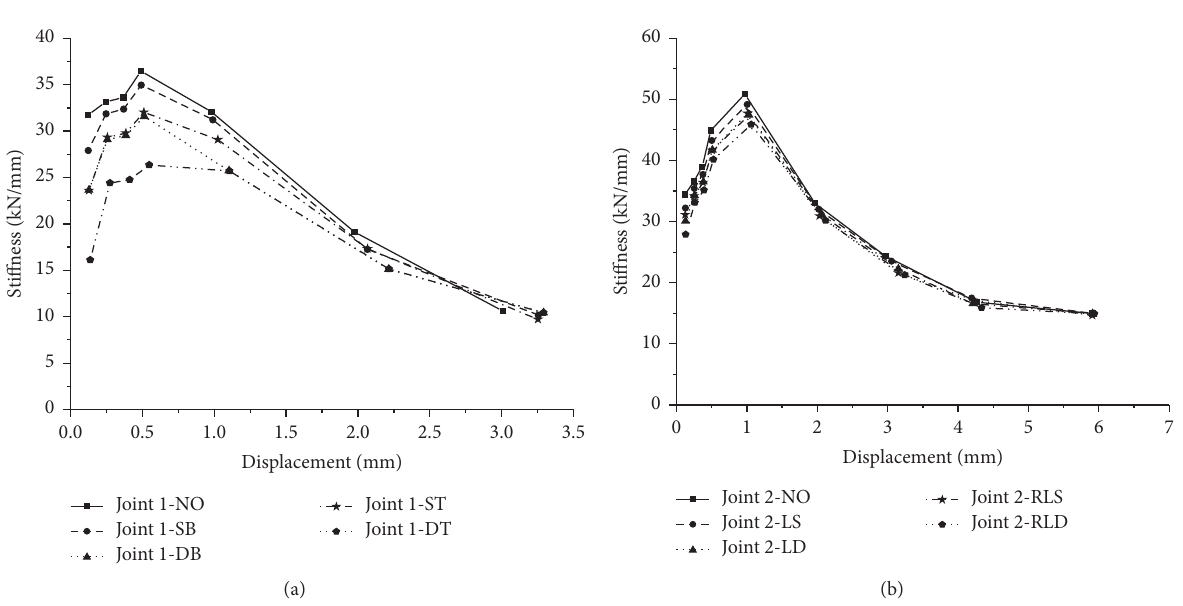
Figure 19: Stiffness degradation observed in bolted glulam joints: (a) Joint 1; (b) Joint